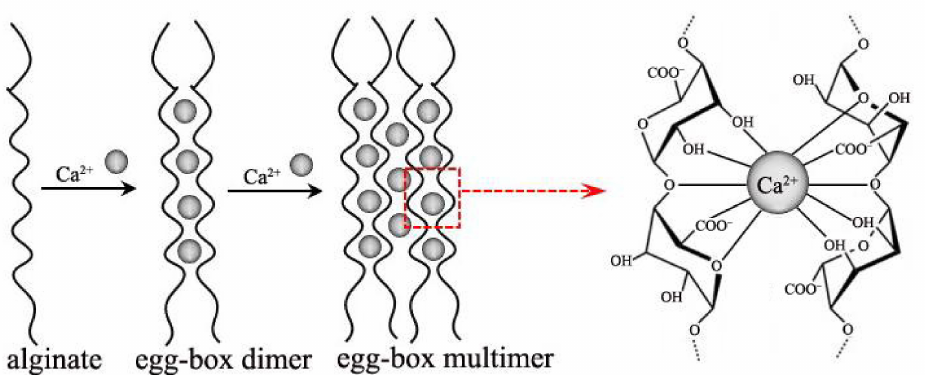
Figure 2. Egg-box junctions of calcium ion and the G block of